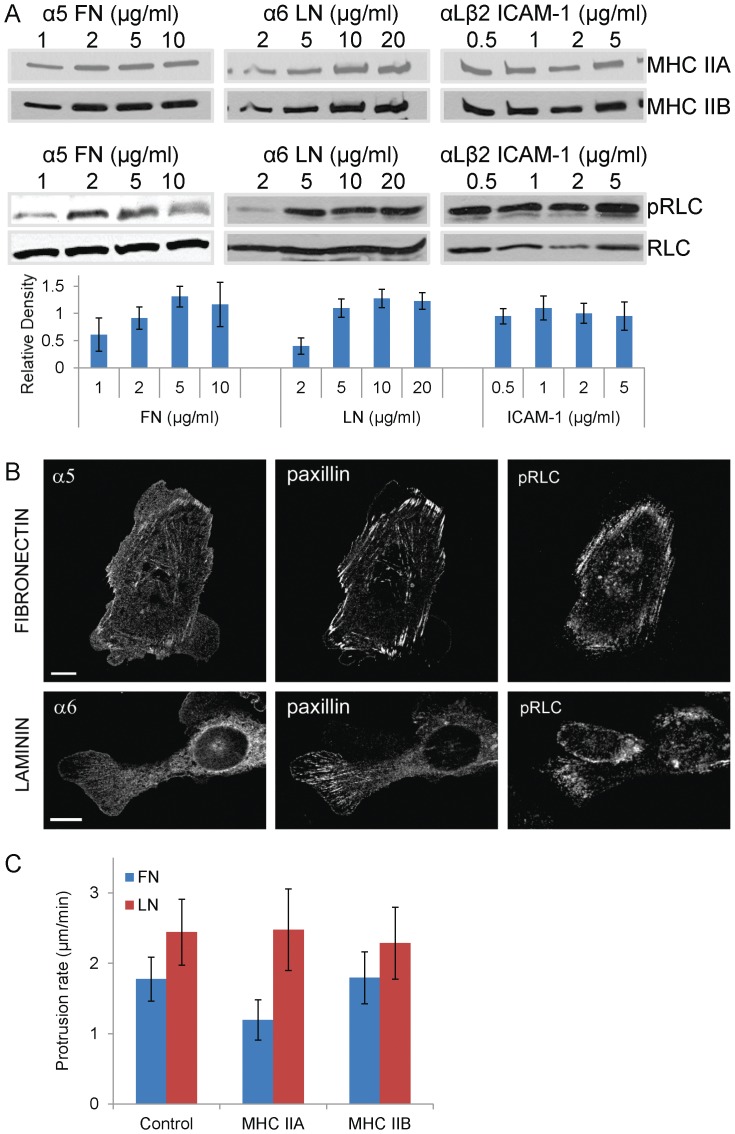
Effect of myosin II on protrusion.(A) CHO.B2 cells transfected with the indicated fluorescently tagged integrin subunit(s) were platted on the indicated substrate for 1 hour, then blotted for MHC IIA, MHC IIB, phosphorylated (p) and total RLC. pRLC does not increase noticeably on ICAM-1 but does on both FN and LN in a dose dependent manner. Note also that MHC IIA and MHC IIB do not change with substrate concentration. Also, the densitometric quantification of pRLC corrected for load using total RLC is shown under each blot. At least three experiments were quantified for each substrate. (B) Adhesion on fibronectin (α5β1) or laminin (α6β1) determines the subcellular distribution of pRLC (Ser19). CHO.B2 cells were (top) transfected with α5-GFP and plated for 60 min on FN (2 µg/ml); (bottom) CHO B2 cells transfected with α6-GFP and plated for 60 min on LN (10 µg/ml). The cells were stained for paxillin and phosphorylated (Ser19) RLC as indicated. Note the more fibrillar distribution of the pRLC in the cells on FN. Scale bar = 10 µm. (C) Over-expression of MHC IIA, but not MHC IIB, inhibits protrusion of CHO.B2 cells on FN but not on LN. CHO.B2 cells were doubly transfected with α5- or α6-GFP and mCherry-MHC IIA or MHC IIB as indicated, then plated on the corresponding substrate (FN for α5, LN for α6). Scale Bar  = 10 µm. Protrusion rates from 4 minute movies were calculated from kymographs and plotted. Data are expressed as the mean ± SD of at least 3 independent experiments. (Protrusion number  = 7, 7, 12, 12, 10, 11, respectively.) P<0.001 for cells on FN expressing ectopic MHC IIA compared to cells expressing ectopic MHC IIB or control cells.